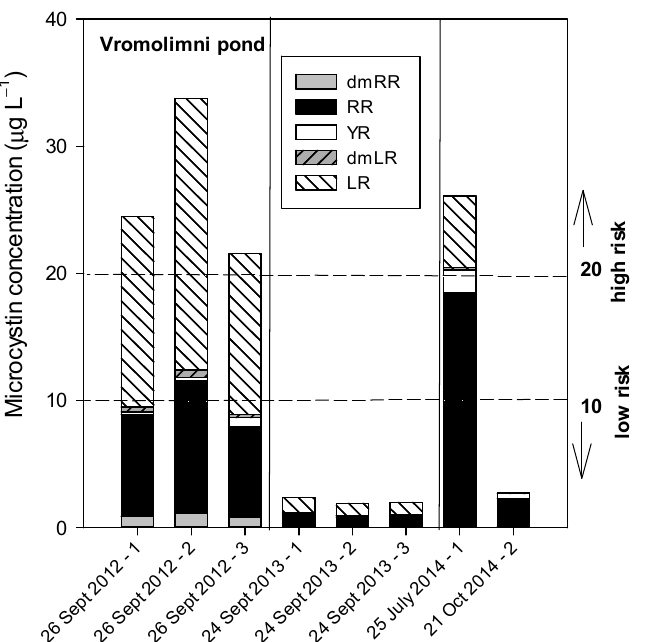
Figure 8. Concentrations ( µ g L − 1 ) of different microcystin variants measured in samples collected on 26 September 2012, 24 September 2013, 25 July and 21 October 2014 at several sites in Vromolimni. MC-variants LY, LW, LF and nodularin (NOD) were not